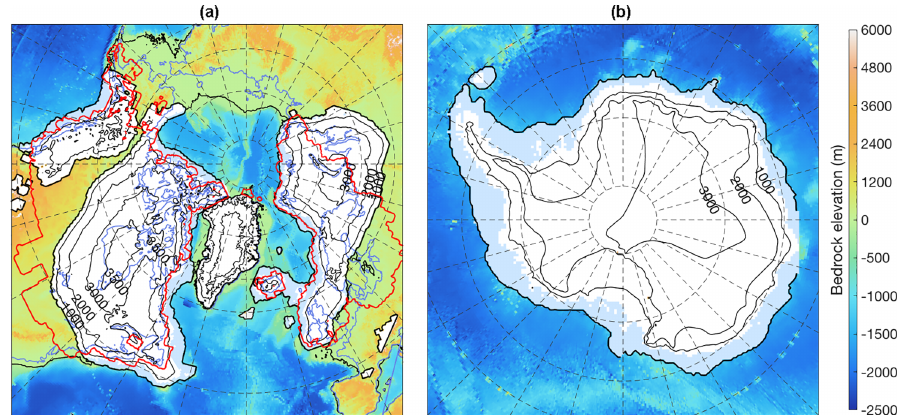
Figure 5. Ice sheets (white) and shelves (light blue) at the LGM over (a) the Northern Hemisphere and (b) Antarctica, as simulated with the default ANICE version from de Boer et al. (2014). Contour lines for the Northern Hemisphere show ice thickness, and contour lines for Antarctica show surface elevation. Bedrock elevation not covered by ice is shown by colours, with present-day shorelines shown in blue and the ICE-5G ice margin shown in